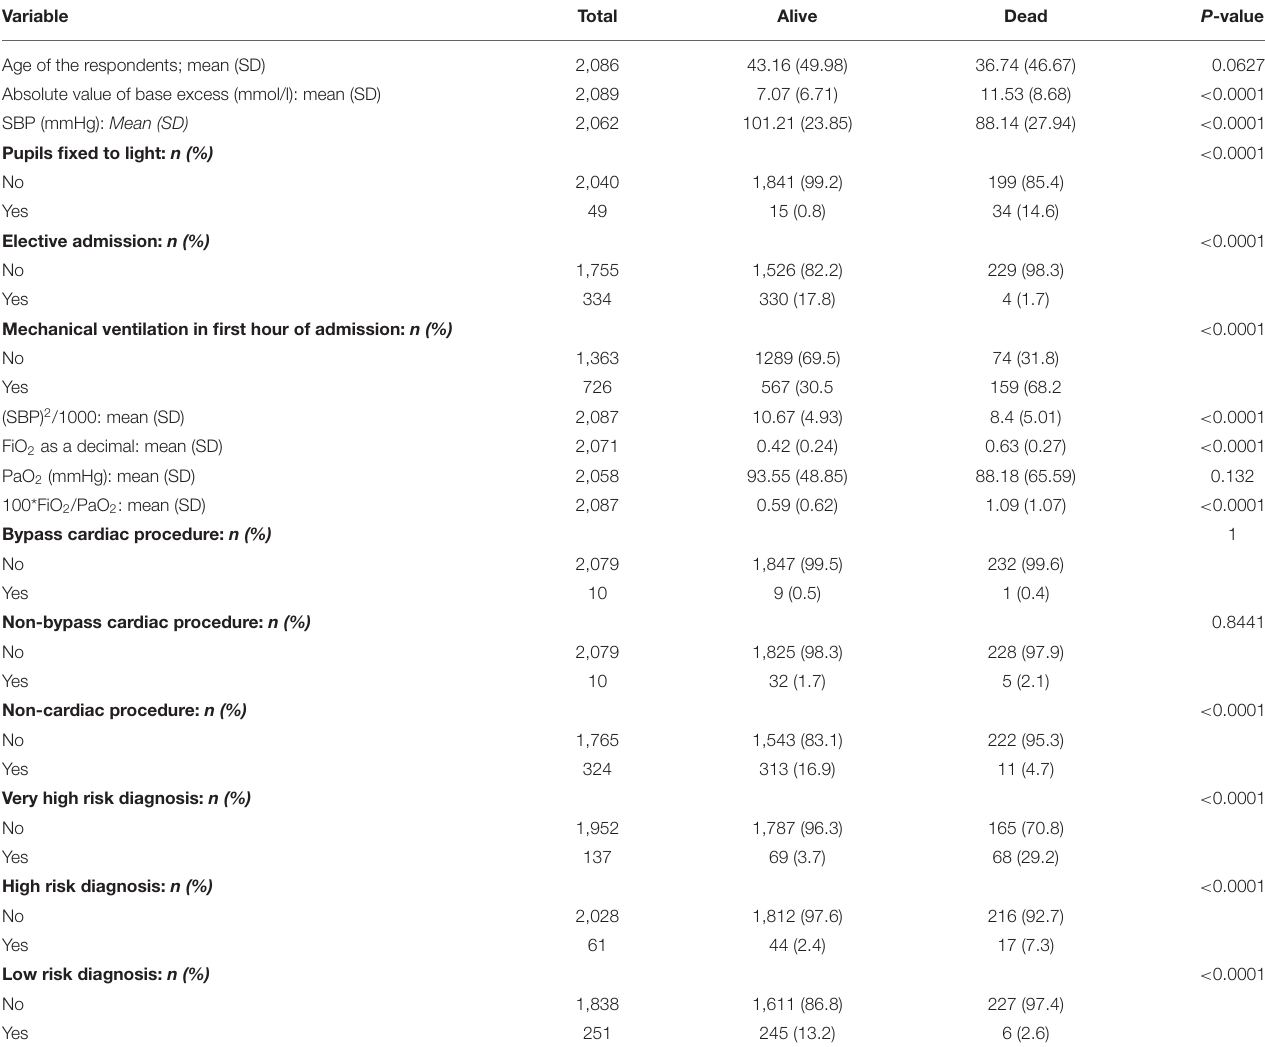
TABLE 2 | Descriptive